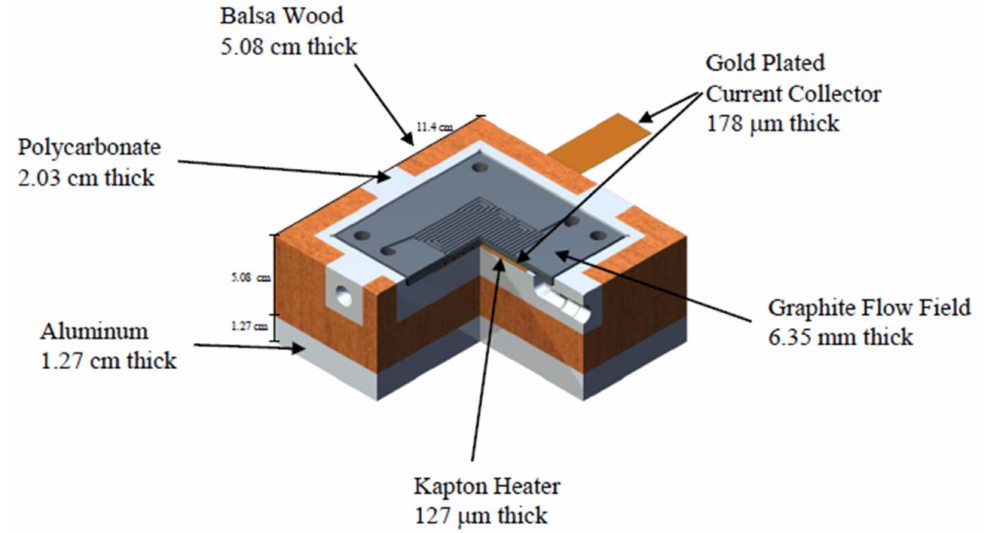
Figure 1. One half of symmetric quasi-adiabatic single-cell hardware. The parallel coolant channels are machined into the backside of the graphite flow field